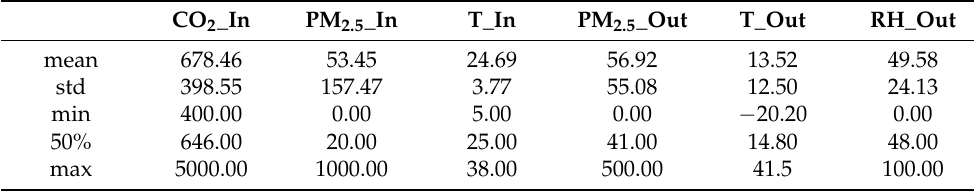
Table 3. The descriptive statistics information of some